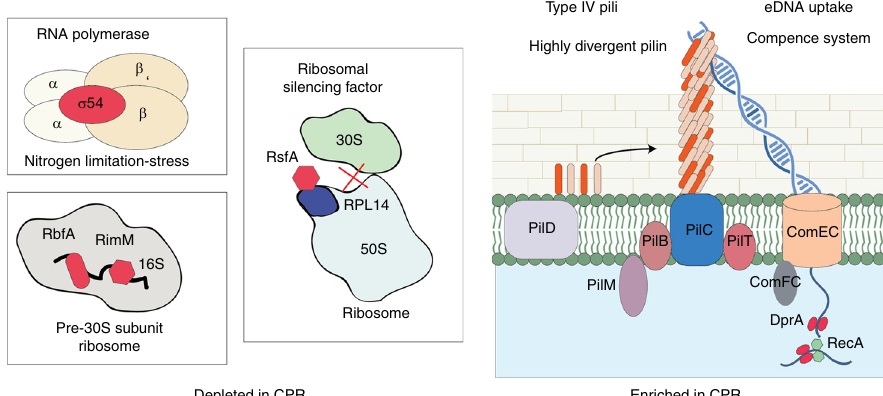
Fig. 5 Example of proteins that are depleted or enriched in CPR. In the left panel are represented four proteins (colored in red) that are involved in informational machineries and are depleted in CPR, yet widespread and important in non-CPR bacteria. In the right panel is represented a schematic model for the type IV pili and the competence systems that appear widespread in CPR